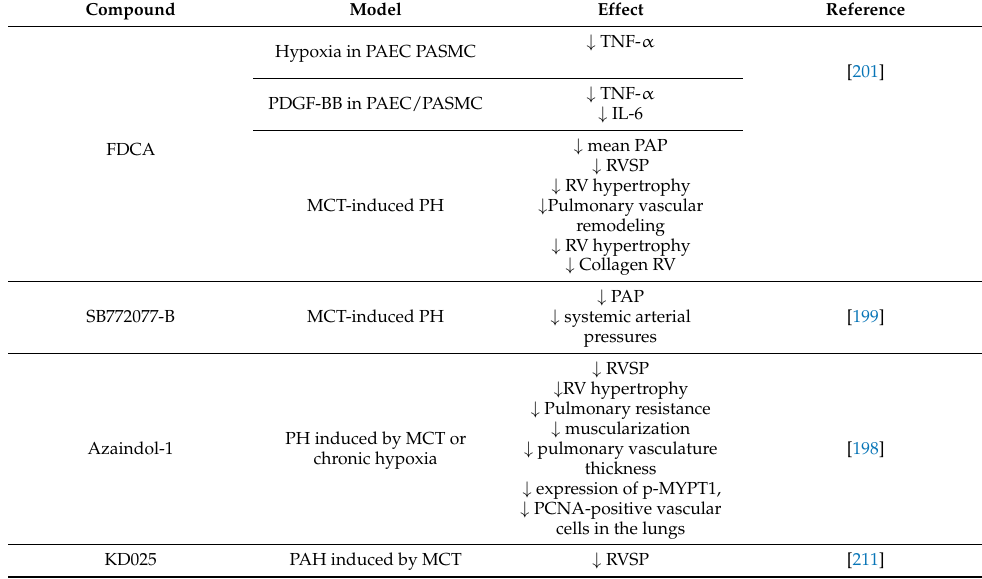
Table 1. ROCK inhibitors other than fasudil and pulmonary